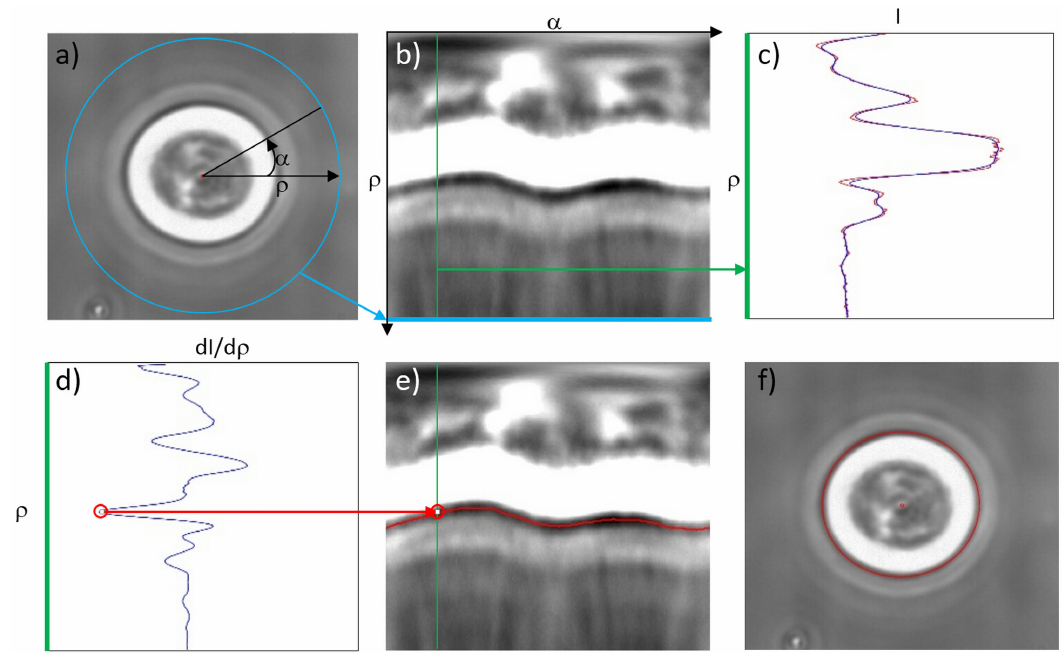
Figure 10. Illustration of the image analysis steps. ( a ) Phase contrast microscope image of a single cell. The center point (red color) of the cell is manually selected and the circular border (light blue color) for the polar transformation is determined by the original rectangular image border; ( b ) The polar-transformed image; ( c ) shows a plot of the gray-scale intensity along the green vertical line appearing in ( b ). The raw data (red line) is smoothed by Fourier filtering (blue line); ( d ) shows the first derivative of the blue-line (intensity) and the red circle shows the point identified as minimum, identified as belonging to cell border; ( e ) by repeating the same procedure for all the polar angles, the cell border is reconstructed on the polar image and ( f ) then transformed back to original